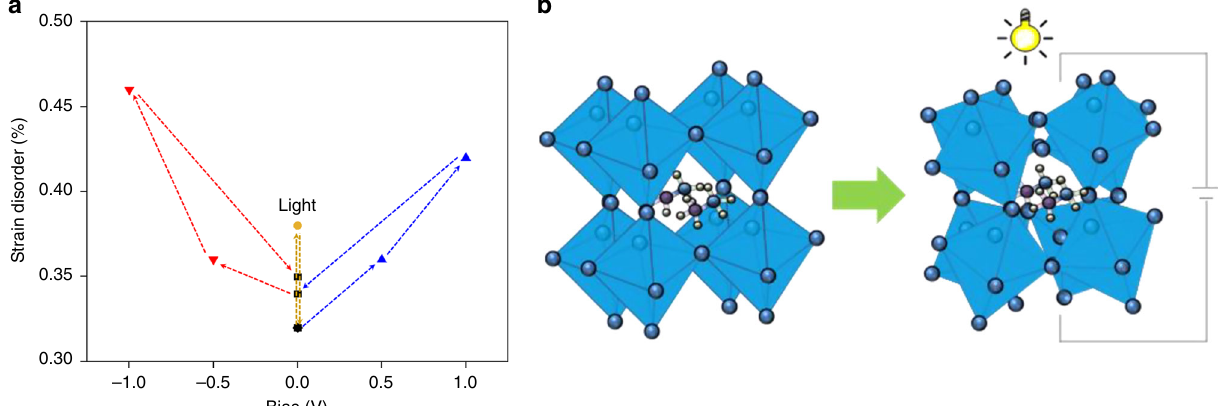
Fig. 5 Photo-induced and bias-dependent Williamson – Hall analysis. a Strain disorder variations under bias and light from successive in-situ XRD measurements (see also Supplementary Figs. 8 and 9). b Schematic illustration of the octahedral distortion induced by bias voltage and light illumination